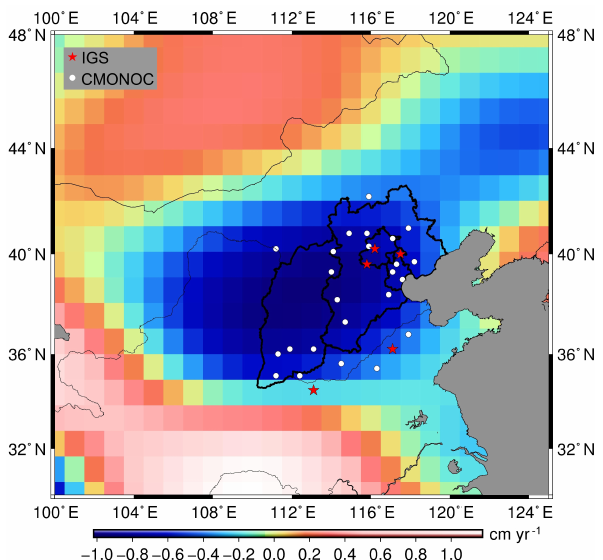
Figure 2. The 2003–2012 secular trend maps (cmyr − 1 ) of the terrestrial water storage (TWS) changes in the North Plain China (NCP) and surrounding regions derived from GRACE data. Results have been destriped and smoothed with a 250km Gaussian smoothing